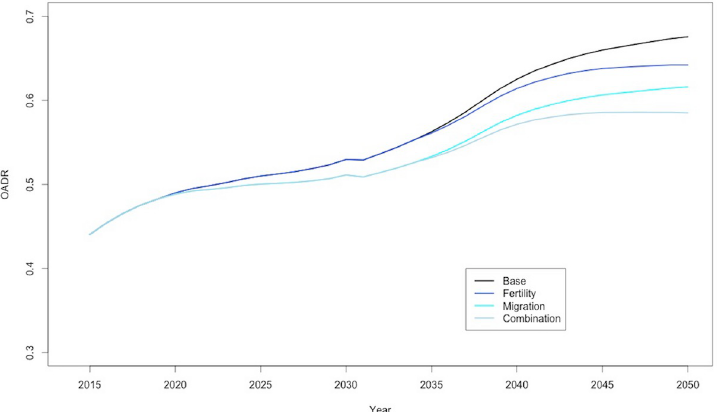
Fig 1. Representative policy time trends, 2015–2050. Base scenario held 2014 mortality, fertility, and migrant population percentage constant. Fertility scenario increased TFR to 1.7 from 2020. Migration scenario introduced 216,000 additional annual immigrants from 2020. Combination scenario applied variables of both fertility and migration scenarios from 2020.